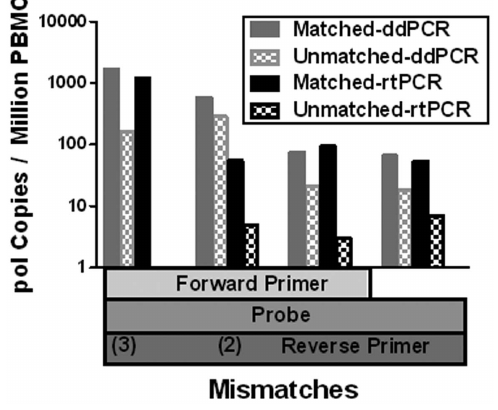
Figure 6. Effect of sequence variation. Patient isolates with previously determined pol sequences that differ from the consensus primer/probe set in at least two positions were analyzed by ddPCR and by qPCR. Both assays were conducted in parallel using the mismatched consensus primer/probe set and a patient-specific matched primer/ probe set. Use of consensus primers and probe resulted in an underestimate of copy number by one to two log 10 by qPCR, with complete loss of detection in the extreme case of 5 total mismatched bases. The underestimate was largely mitigated (mean 57% reduction in log 10 copy number change) by ddPCR in all cases. These 4 cases reflect the most extreme mismatches observed in 84 patients, suggesting that sequence variation is unlikely to significantly impact ddPCR assay results in clinical studies. All samples analyzed were HIV-1 subtype